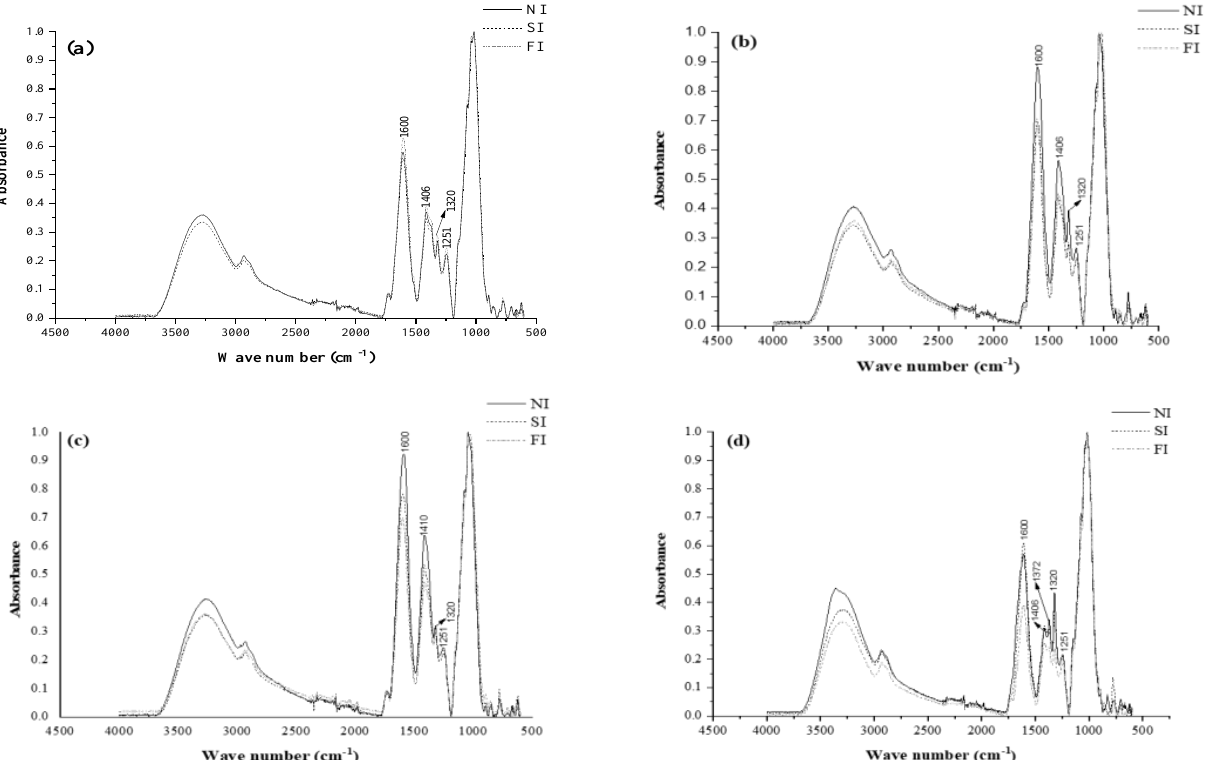
Figure 1. Fourier − transform infrared spectra of freeze-dried mucilage of ‘Amarilla Olorosa’ ( a ), ‘Cristalina’ ( b ), ‘Dalia Roja’ ( c ), and ‘Roja Lisa’ ( d ) cactus pear varieties, subjected to three irrigation regimes: non-irrigated (NI, control), supplemental irrigation (SI), and full irrigation (FI). The absorption band between 1700 and 1600 cm − 1 indicates the stretching of the C=O bond of the amide group, indicating the presence of proteins. The absorption band at 1407 cm − 1 probably corresponds to the -OH radical of polyphenolic compounds. The absorption bands between 1320 and 1210 cm − 1 correspond to the stretching of the C-O bond of carboxylic acids and indicate the presence of uronic acid. The absorption band between 1085 and 1045 cm − 1 is attributed to monosaccharides such as glucose and the absorption band at 895 cm − 1 corresponds to anomeric β -carbon, indicating the presence of β -type glycosidic bonds in mucilages